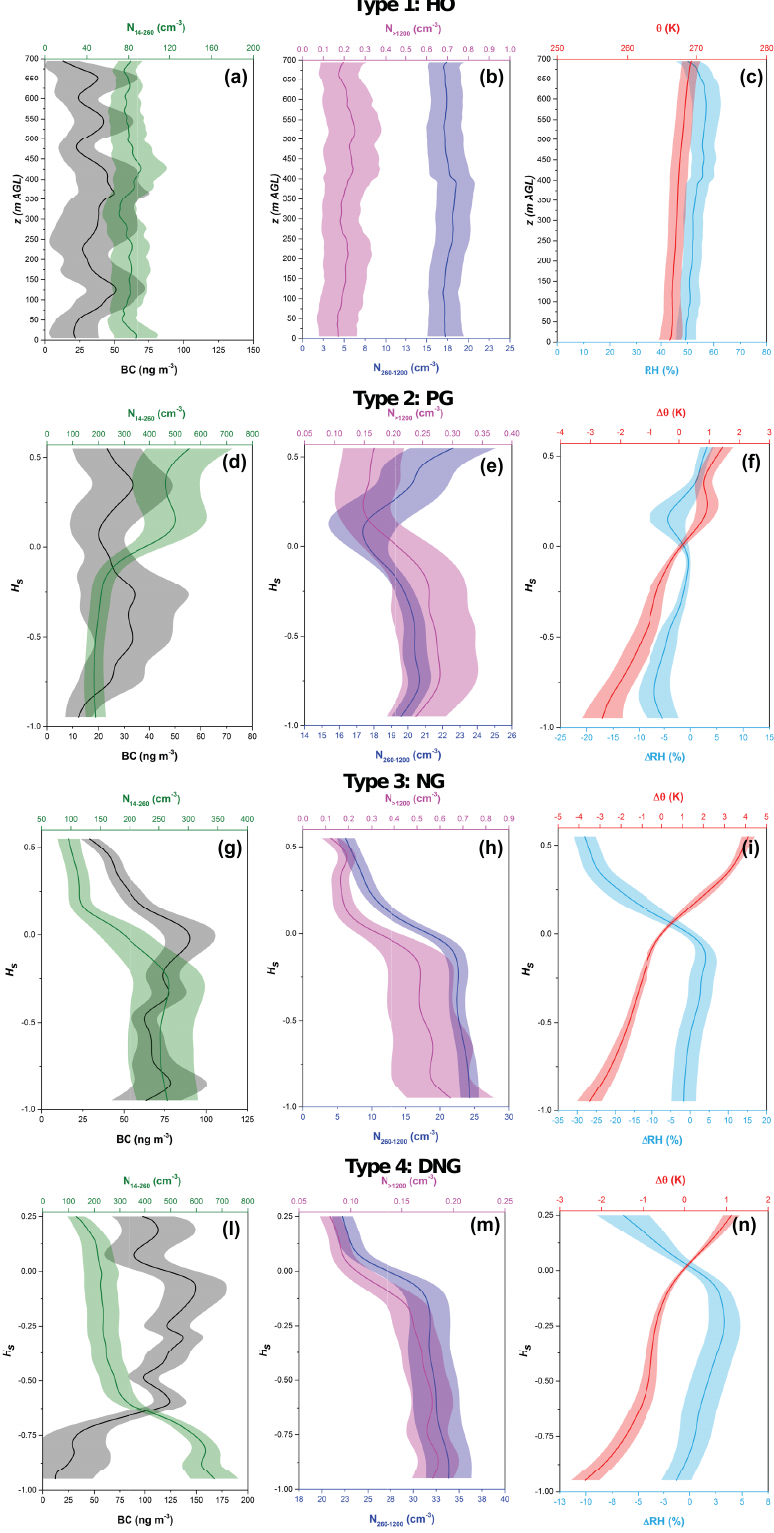
Figure 4. Springtime statistical mean profiles of N 14 − 260 (green line), BC (black line), N 260 − 1200 (blue line), N > 1200 (magenta line), θ (red line) and RH (light blue line) along height over Ny-Ålesund for the four typologies of vertical profiles: (a) – (c) homogeneous profiles (HO); (d) – (f) positive gradient profiles (PG); (g) – (i) negative gradient profiles (NG); (l) – (n) decoupled negative gradient profiles